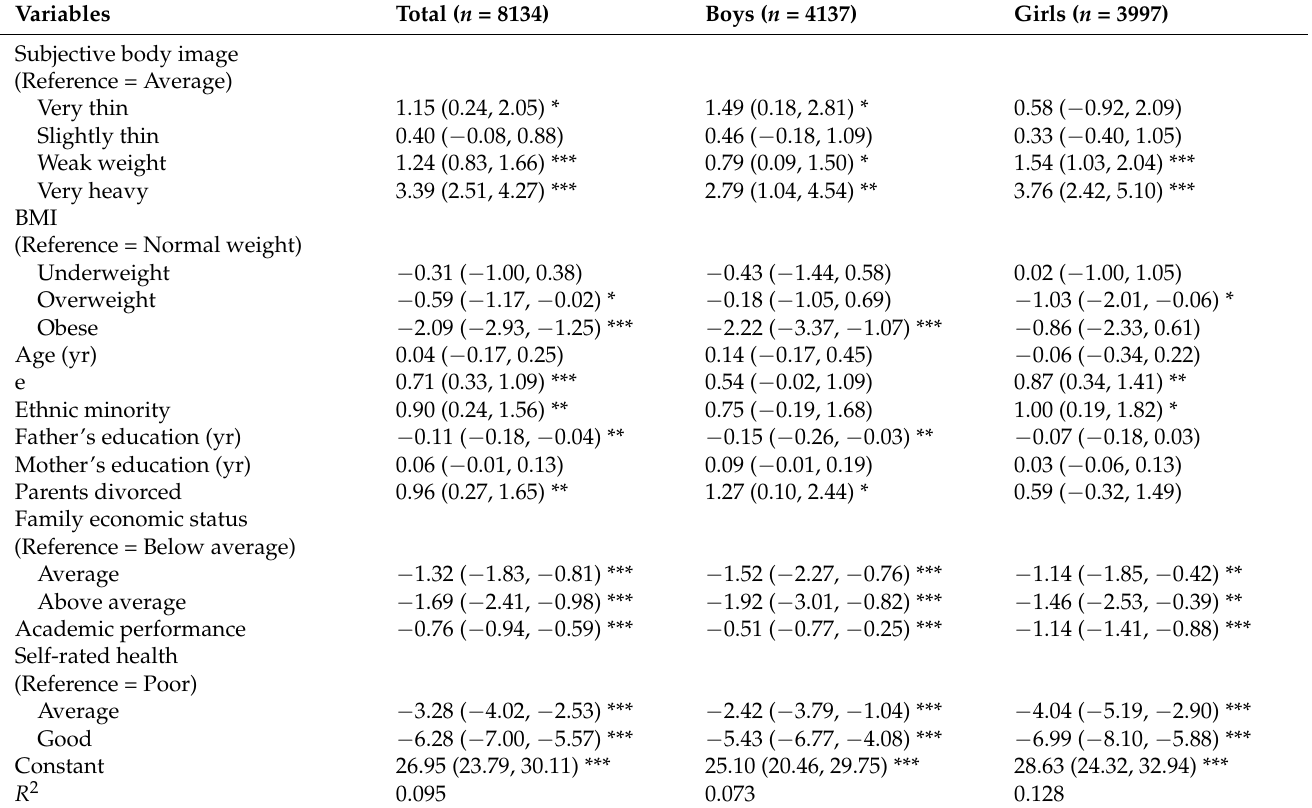
Table 3. Multiple linear regression analyses of the association between SBI, BMI and psychological